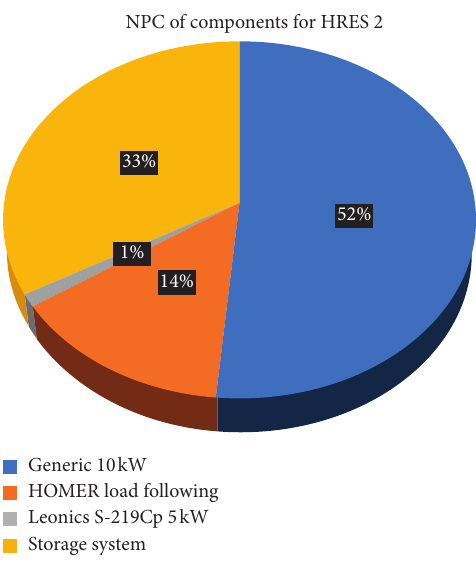
Figure 9: Details of NPC by components of HRES 2.